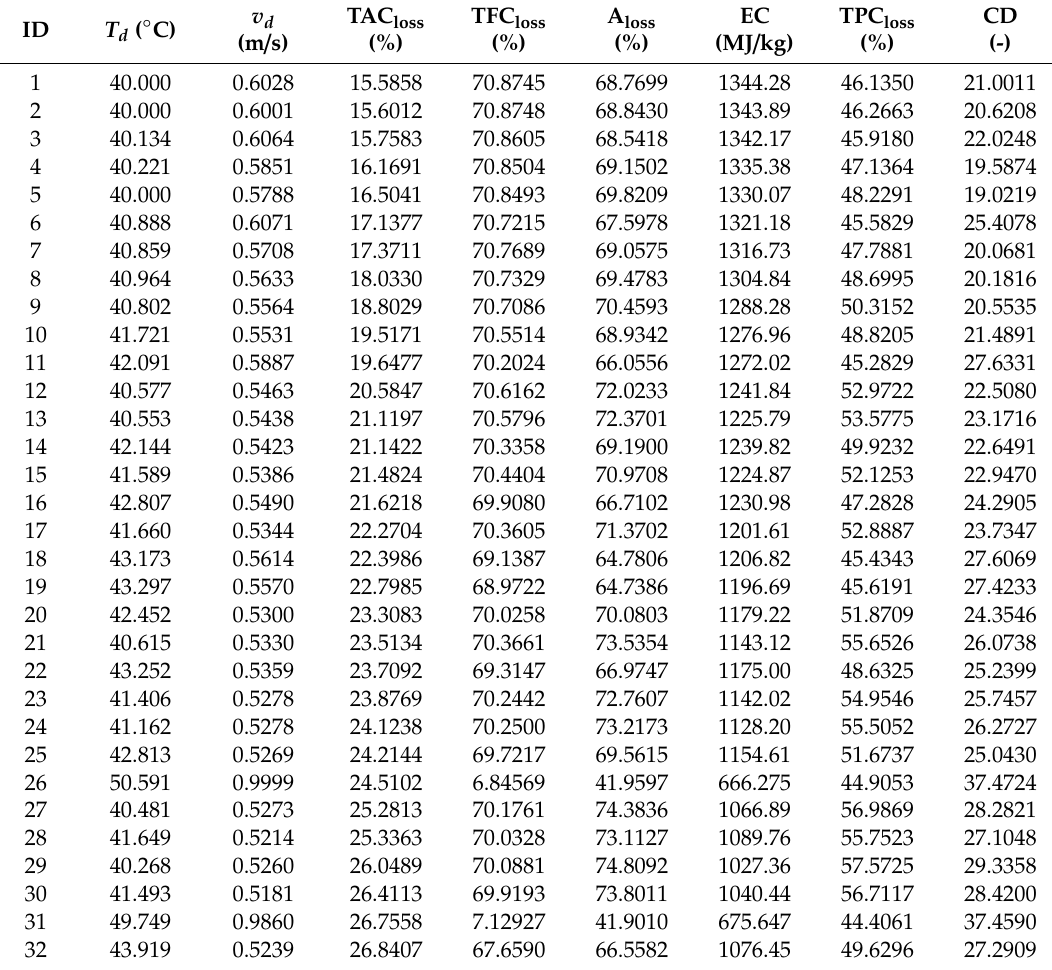
Table A1. Pareto optimal